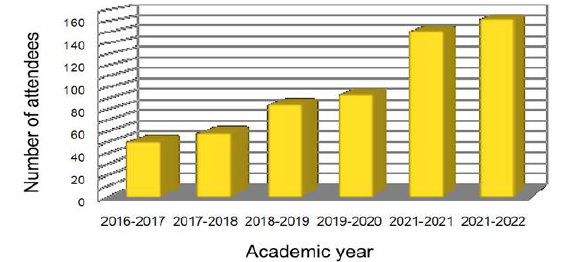
Figure 1 . Number of practitioners attending the Master all over the academic years (Figure by P.